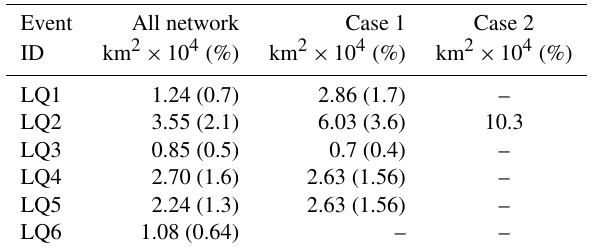
Table 2. Results of the assessment of differences between areas with LLL > 0.95 when reducing the number of stations used for the inter- polation. In case 1, we removed all stations triggered between 0 and 5s, i.e., up to ∼ 50km from the event. In case 2, we removed sta- tions triggered between 0 and 10s, i.e., up to ∼ 65km. Missing val- ues are because of lack of stations for reliable interpolation. Values in percentage are computed with respect to the entire interpolation grid, i.e., 1 . 71 × 10 6 km 2